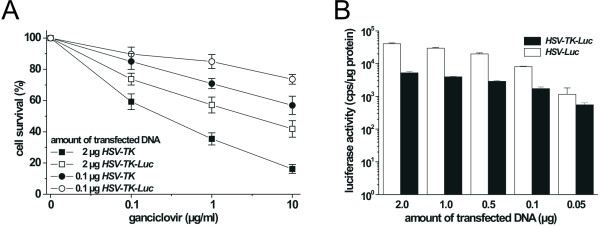
Comparison of the enzymatic activities of the HSV-TK-Luc fusion protein, HSV-TK, and Luc. U87MG cells were transiently transfected with 0.05 – 2 μg of HSV-TK-Luc, Luc, or HSV-TK plasmid. Cells transfected with equimolar amounts of DNA were analyzed for cytotoxic and bioluminescent activity. (A) Cytotoxic activity of cells transfected with HSV-TK-Luc or HSV-TK. For reasons of clarity only the graphs for 0.1 μg and 2 μg of transfected DNA are shown. (B) Luciferase activity in U87MG cells transfected with HSV-TK-Luc or Luc only. Results represent 3 independent experiments.